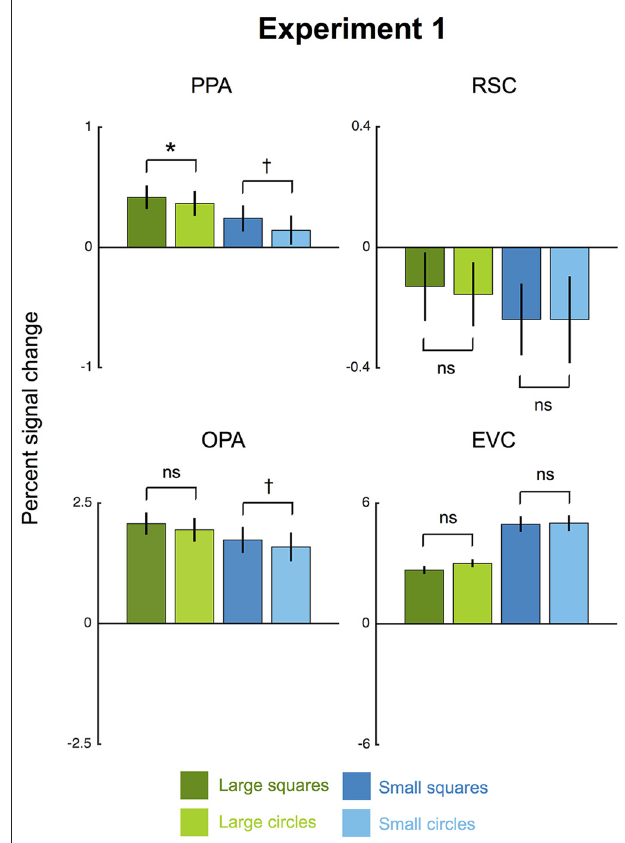
FIGURE 2 | Results for Experiment 1. Average percent signal change ( ± 1 SEM) to large and small squares (high-rectilinearity) and circles (low-rectilinearity) is shown for each region of interest (ROI) averaged across hemispheres. The parahippocampal place area (PPA) and occipital place area (OPA) both showed a significant main effect of shape, with greater overall responses to squares than circles. ( † p < 0.07; ∗ p < 0.05).